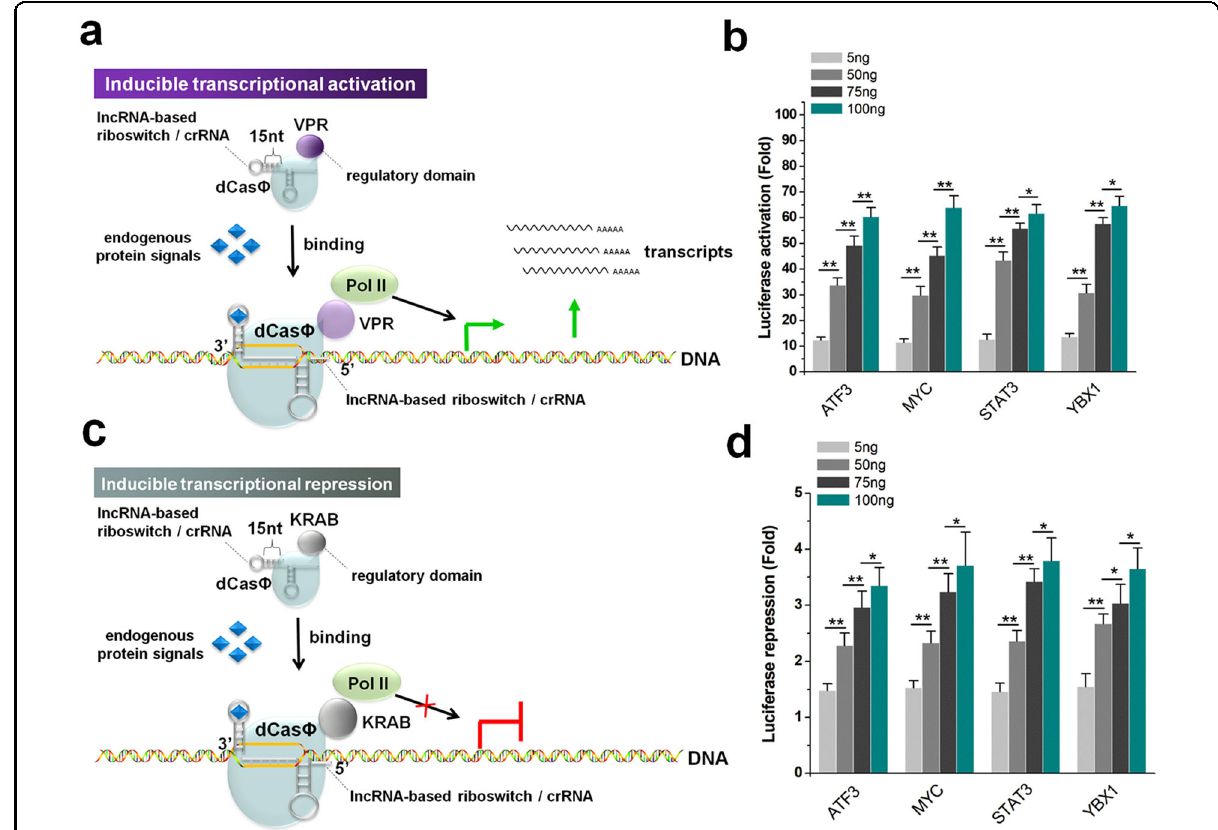
Fig. 3 Protein signal-inducible transcriptional activation/inactivation. a Schematic diagram showing the molecular mechanism of transcription activation of cellular genes induced by endogenous proteins. The device linked an internal protein to the transcriptional activation of a downstream gene. b The effect of gene activation was detected by the dual-luciferase reporter assay. Relative luciferase activities were determined as the ratios of Rluc to Fluc values. The fold change in each group was determined by comparison with the crRNA negative control. c Schematic diagram showing the molecular mechanism of transcription repression of cellular genes induced by endogenous proteins. The device linked the presence of internal protein to the transcriptional inactivation of a downstream gene. d The effect of gene inactivation was detected by the dual-luciferase reporter assay. The fold change in each group was determined by comparison with the crRNA negative control. All values represent the means ± SD from fi ve independent experiments. * P < 0.05; ** P < 0.01, relative to the control, two-tailed t